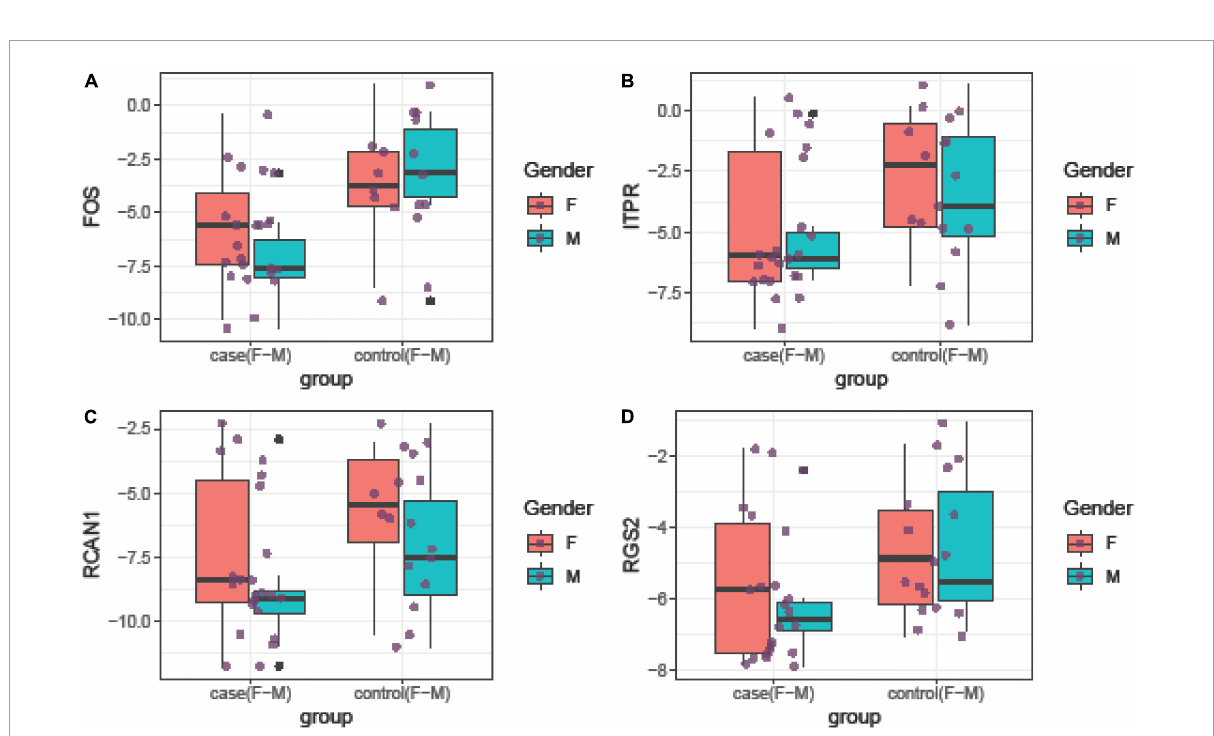
FIGURE2 Relative expression amounts of FOS (A) , ITPR (B) , RCAN1 (C) , and RGS2 (D) genes in blood samples of patients with periodontitis compared with